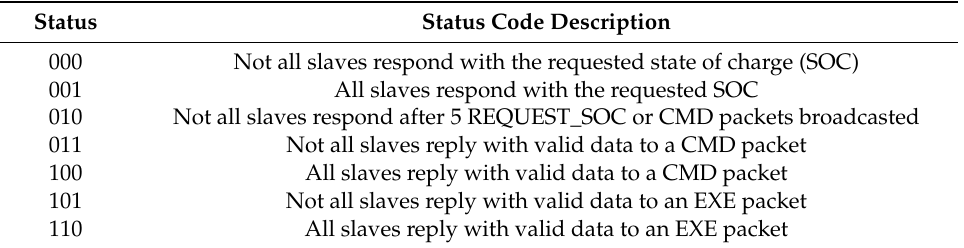
Figure 7. Master application layer as a state machine. Table 2. Command execution status.